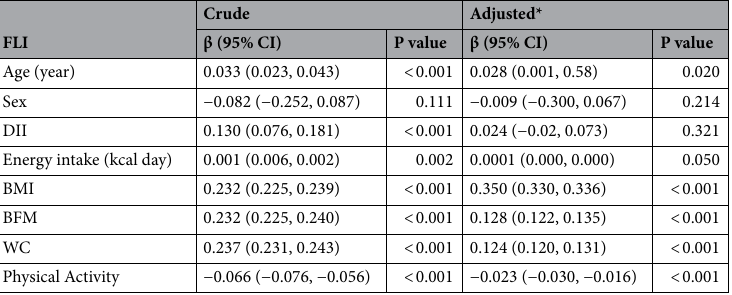
Table 3. Association between selected variables and fatty liver index by l inear regression analysis. *Adjusted for current smoker, use alcohol, FBS and lipid profile (LDL-C, HL-C, TG and total cholesterol).